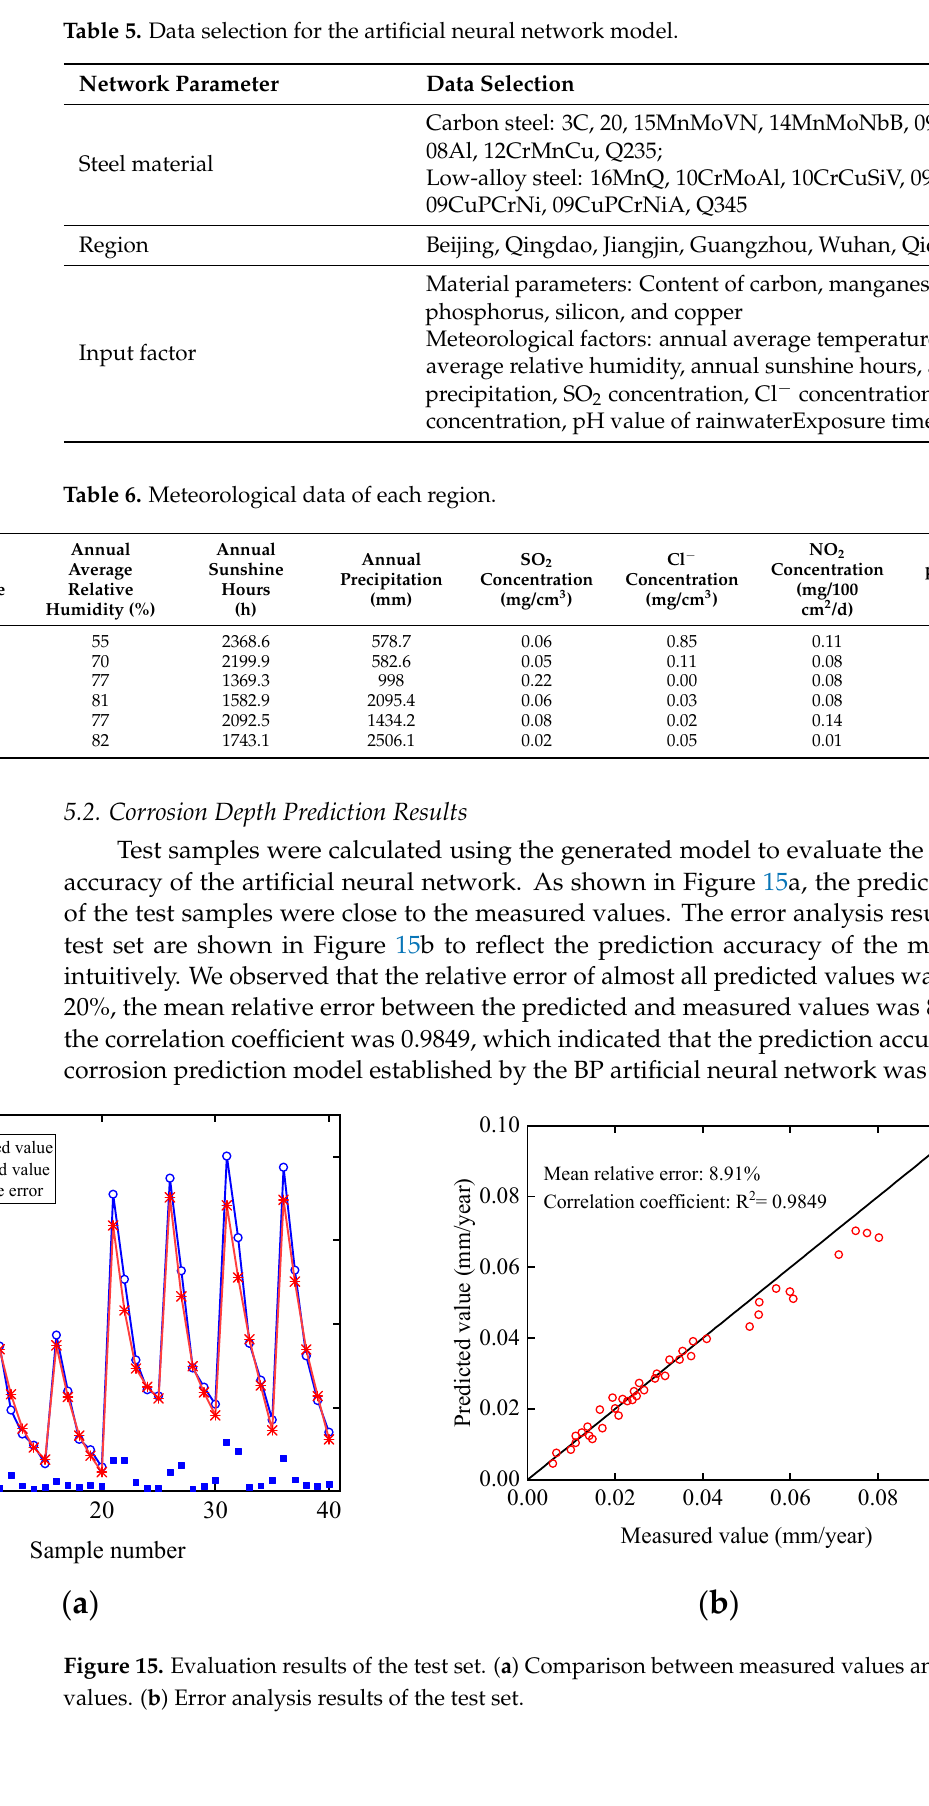
values. ( b ) Error analysis results of the test set.